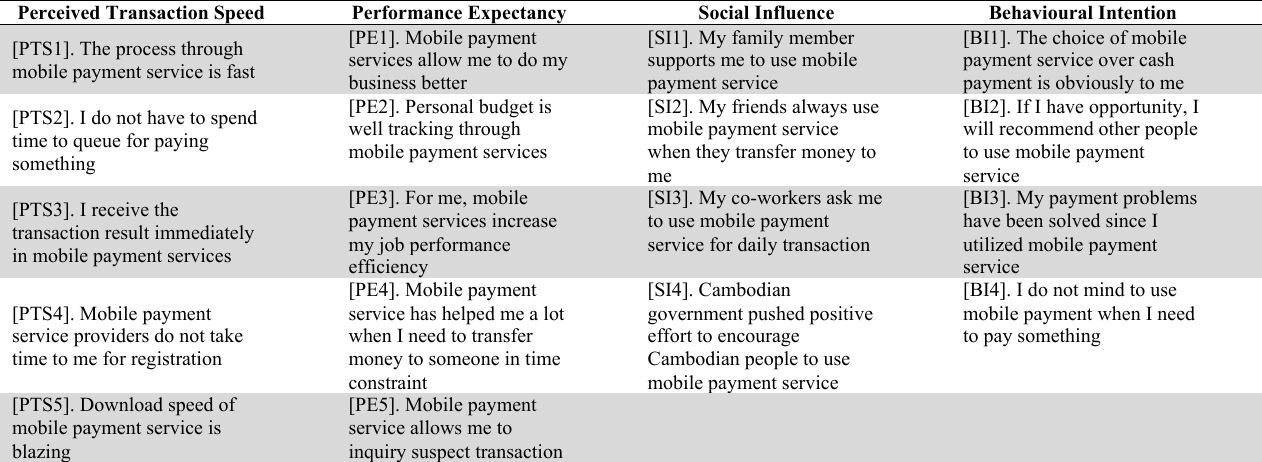
Operationalization of